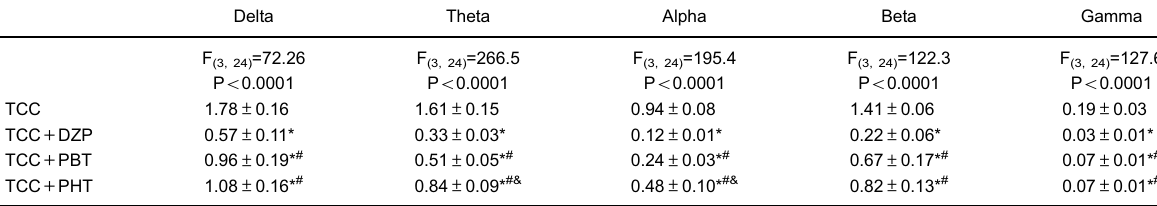
Table 2. Relative bandpower of brainwaves measured in mV 2 /Hz (cid:1) 10 – 3